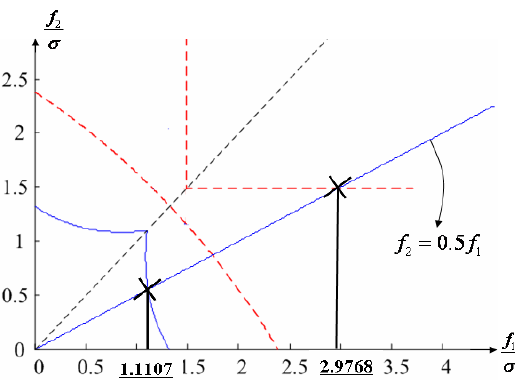
Figure 16. Accommodation rule for 1 st and 2 nd faulty sensors in Figure 12.